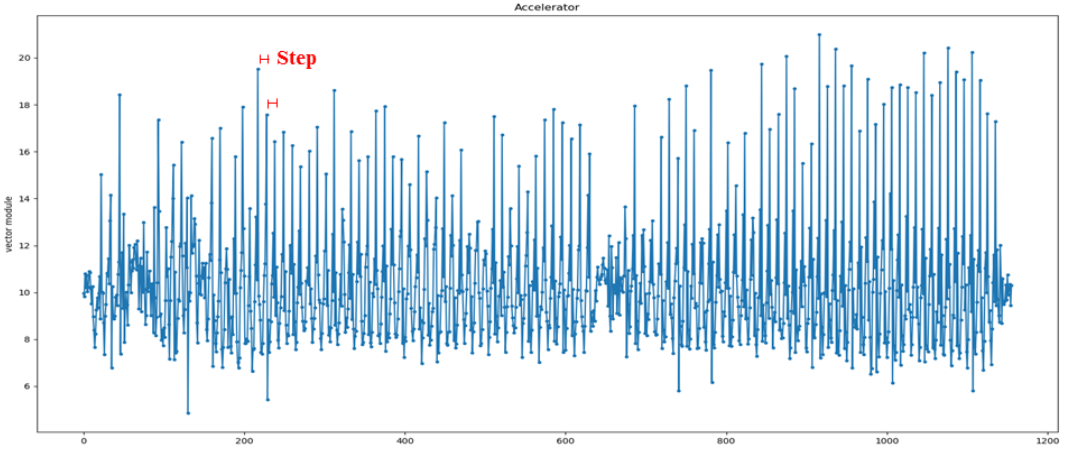
Figure 4. The vector module of accelerator readings for